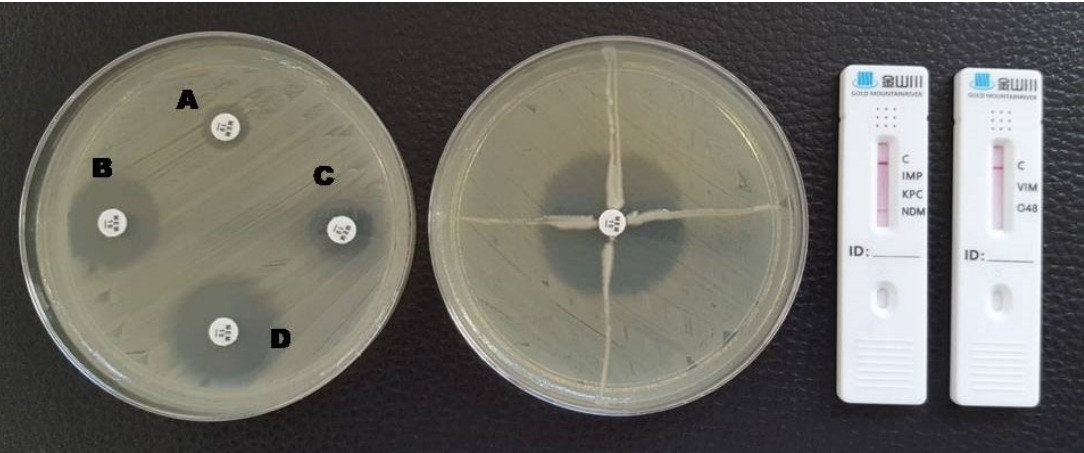
Figure 3. Phenotypic and lateral flow assay results for an NDM ‐ producing K. pneumoniae . A: meropenem disc without inhibitors; B: meropenem + EDTA; C: meropenem + phenylboronic acid; D: meropenem + EDTA + phenylboronic acid. The Hodge test was negative and a red line in the NDM test area is visible in the LFA.